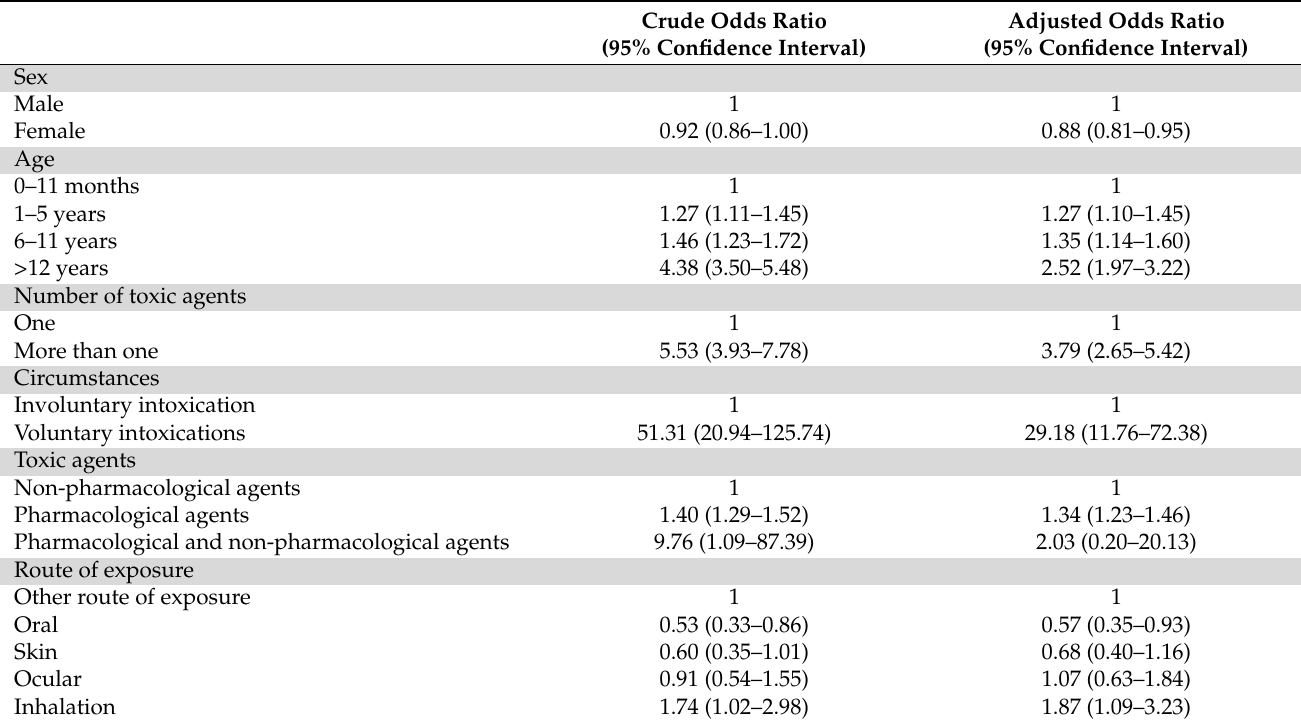
Table 3. Risk of ED visit or hospitalization according to demographic and clinical characteristics.